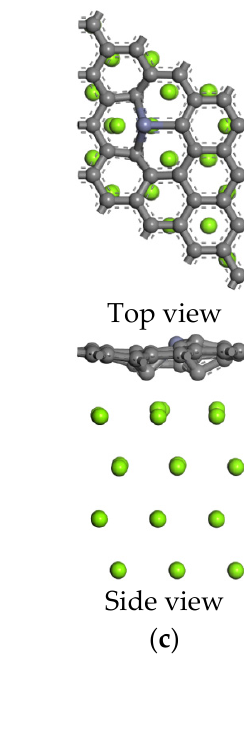
Figure 6. The intrinsic interface model: ( a ) side view; ( b ) top view (the position of the C atom surrounded by C1, C2, and C3 is the position of the doped atom).